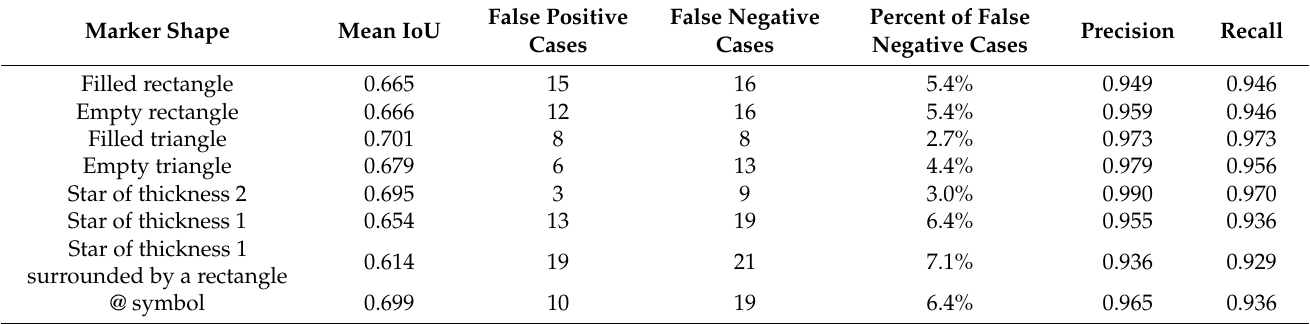
Table 2. The comparison of eight tested initial marker shapes of the first iteration.